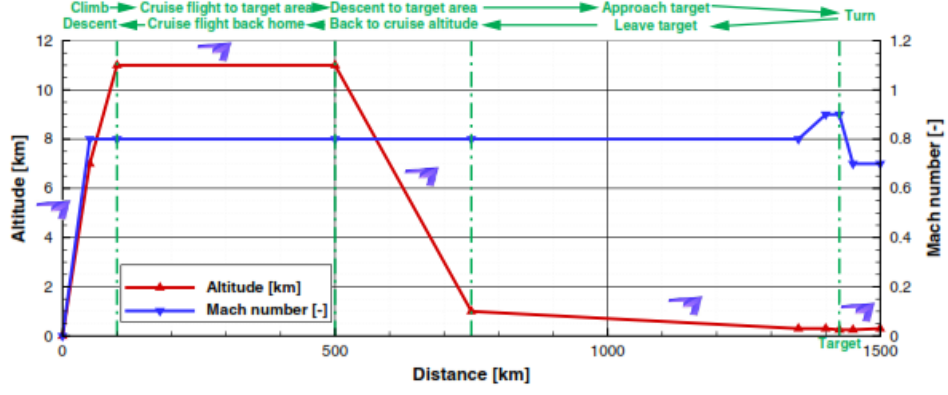
Figure 5. Design Mission of SACCON UCAV